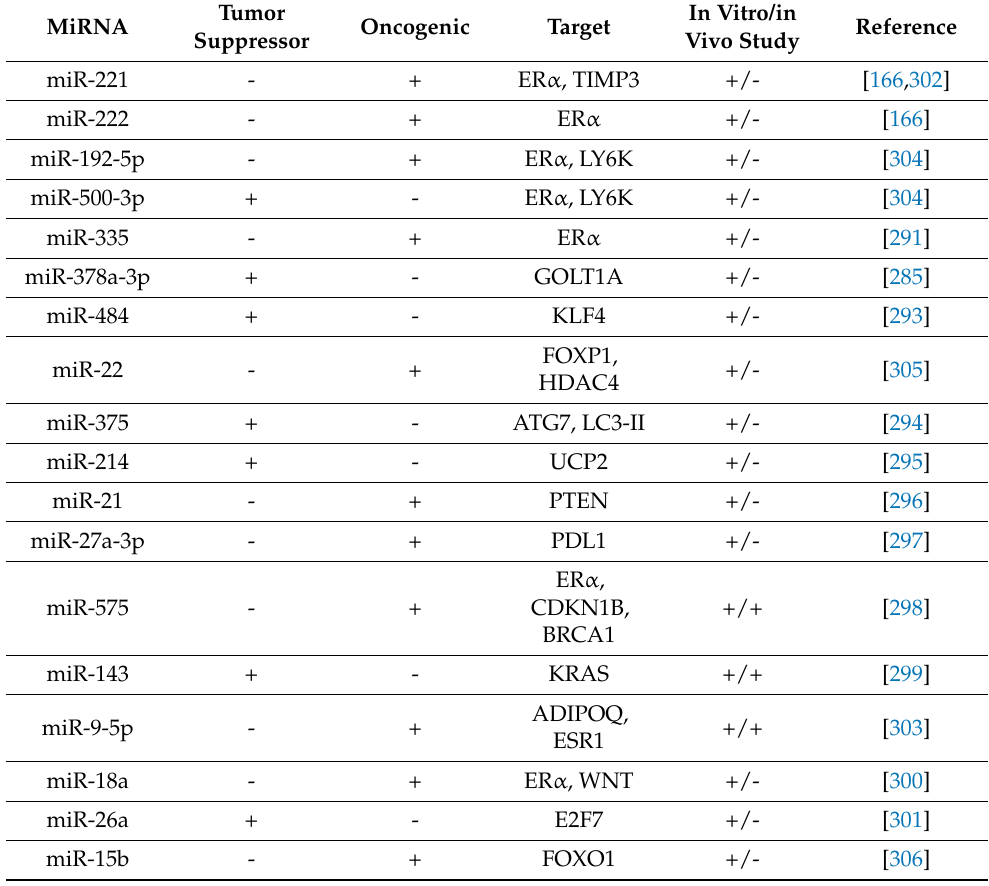
In Vitro/in Reference Vivo Study